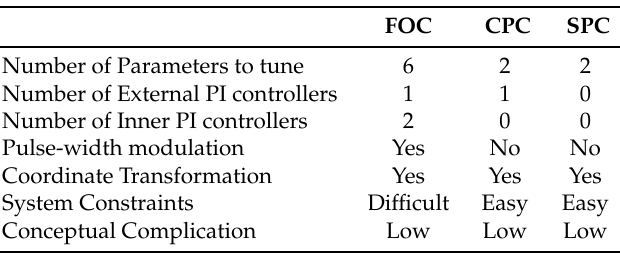
Table 1. Comparative elements in theory.